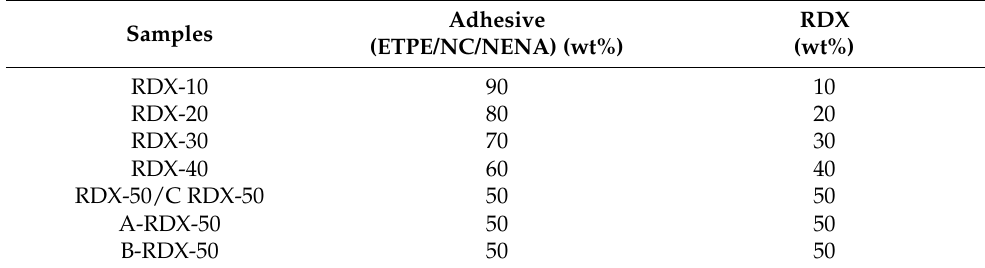
Table 2. Model propellants with different RDX